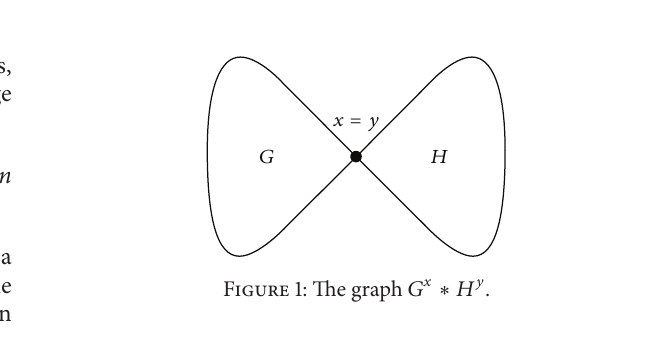
Figure 1: The graph 𝐺 𝑥 ∗ 𝐻 𝑦 .